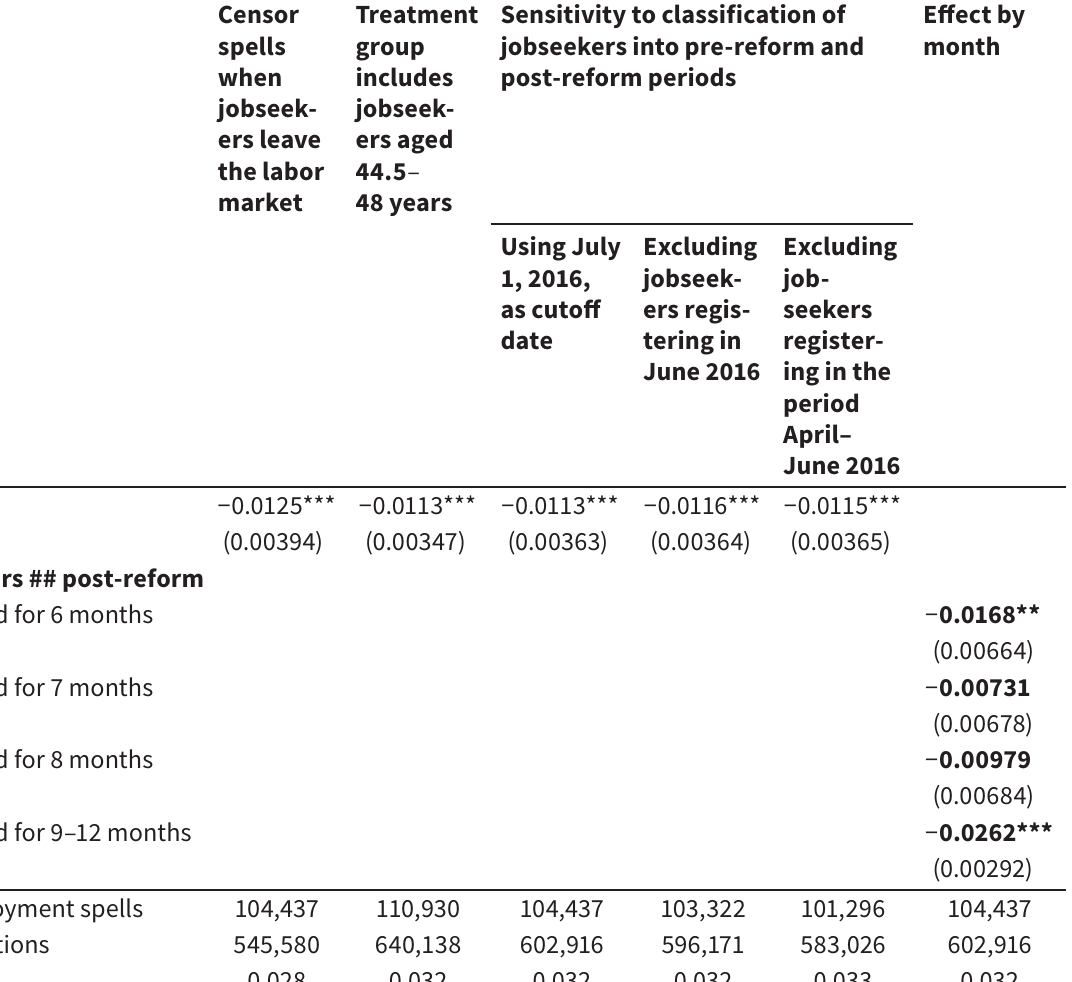
The effect of the subsidy on the job-finding rate: robustness